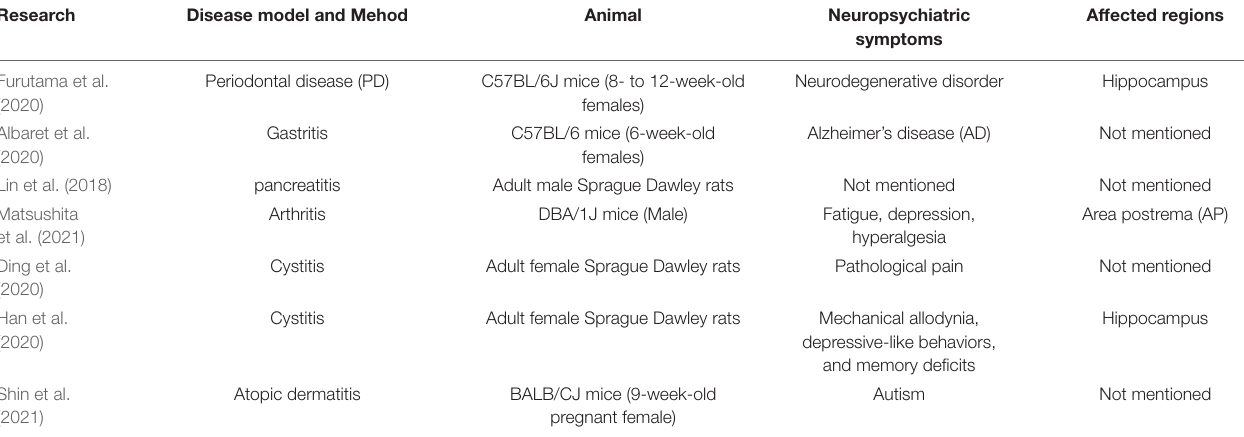
TABLE 2 | Animal experiments on the relationship between inflammation in peripheral organs and in the